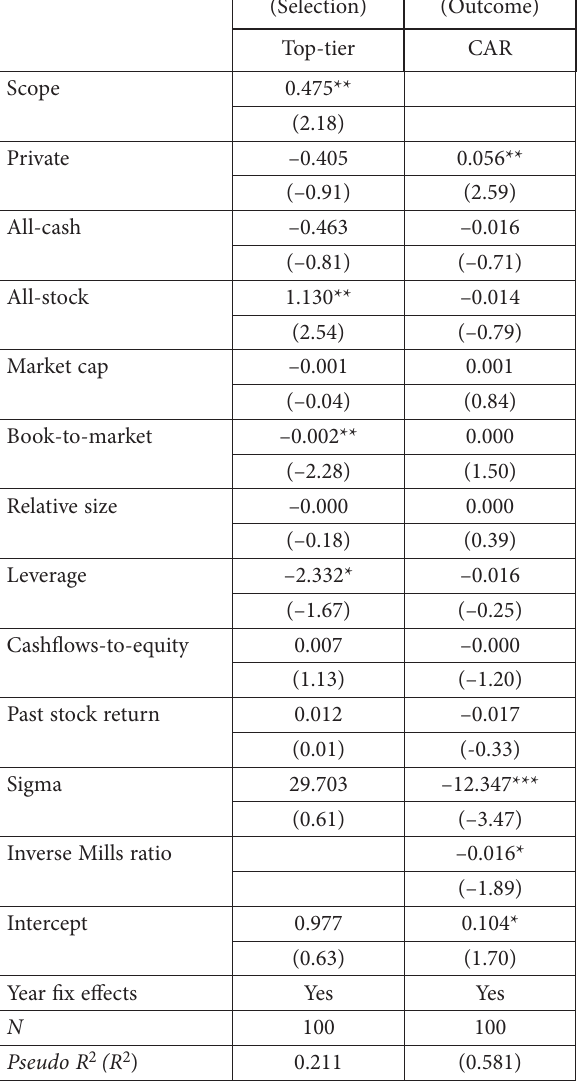
Table 7. Heckman two-stage